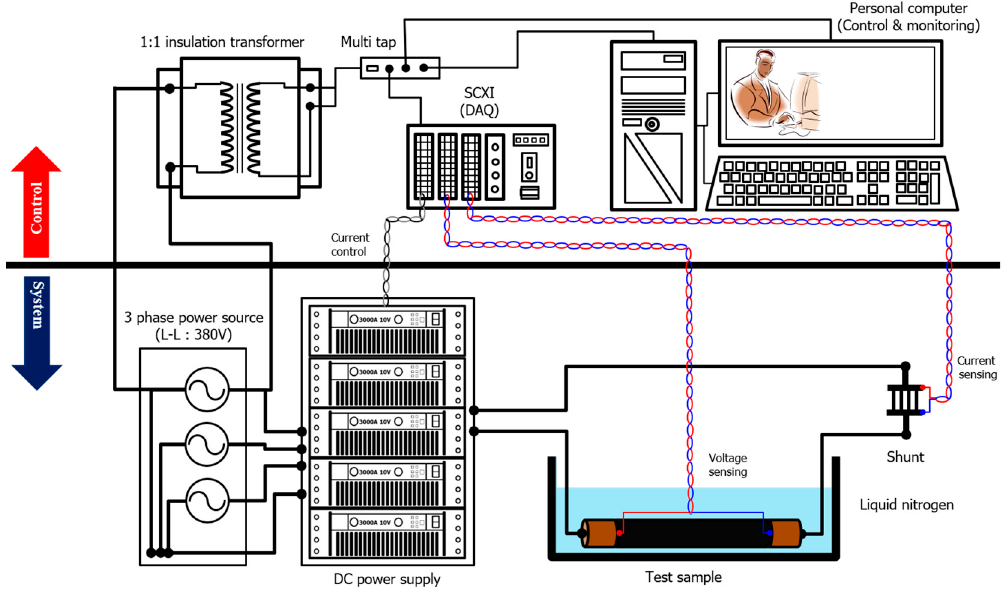
Figure 9. Configuration concept of the DC Ic measurement for the 6-m-long tri-axial HTS power cable.